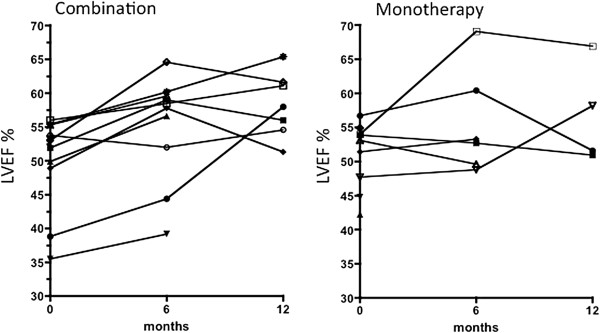
Baseline, 6 month and 12 month LVEF for each patient in DFO monotherapy and DFP combination arms. With DFP combination, mean LVEF increased from 49.9% to 55.2% at 6 months (n = 10) and to 58.3% at 12 months (n = 7): with monotherapy LVEF increased from 52.8% to 55.7% at 6 months (n = 6) and to 56.9% at 12 months (n = 4). The improvements are significant over time in both arms (p = 0.04) but without significant difference between arms (p = 0.86 for treatment; p = 0.89 for the interaction).